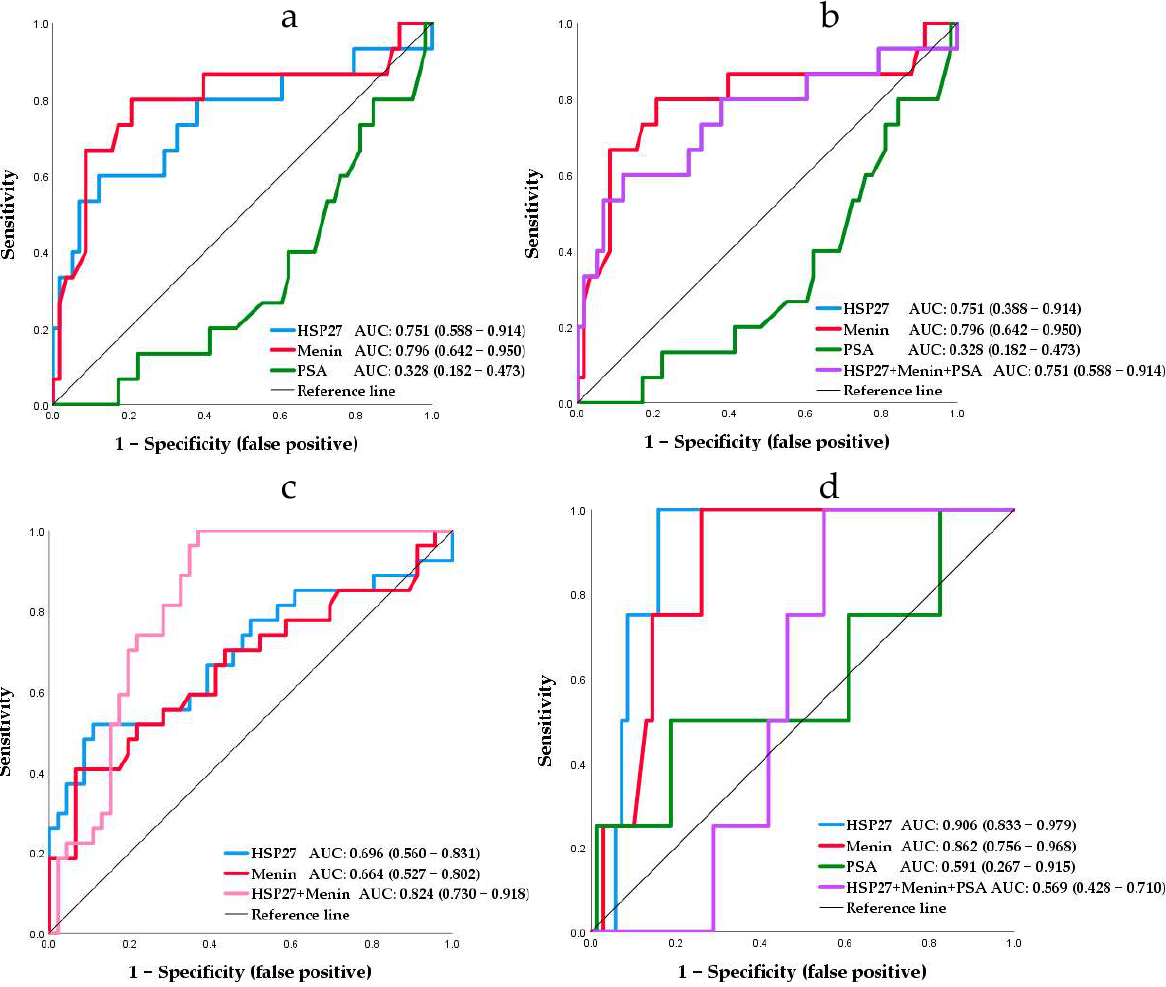
Figure 6. ROC analysis. ( a , b ) HSP27, Menin, PSA compared to death; ( c , d ) HSP27, Menin, PSA compared to aggressivity. HSP27: heat shock protein, PSA: prostate specific antigen, ROC: receiver operating characteristic, AUC: area under